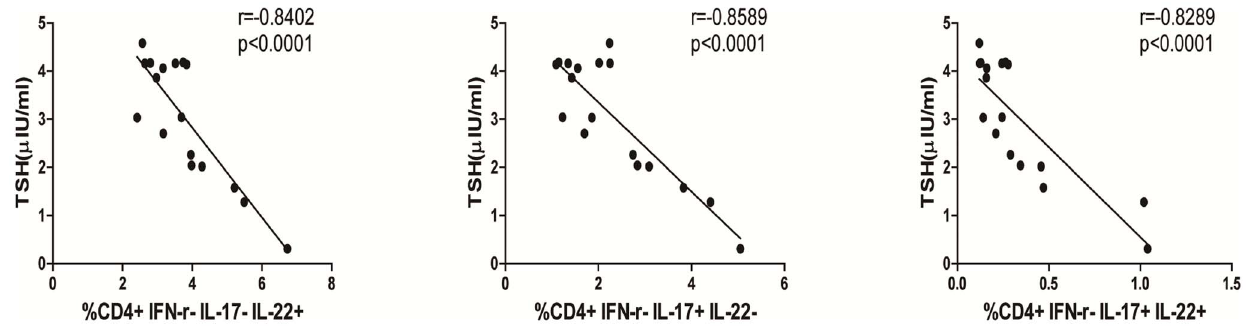
Figure 3. Correlation between percentages of different subsets of CD4 + T cells and levels of serum TSH in newly diagnosed HT patients. The potential correlations between the levels of serum TSH and the percentages of Th22, Th17 cells in the HT patients were analyzed by Spearman’s rank correlation test. Data shown are the mean values of individual patients (n=17).